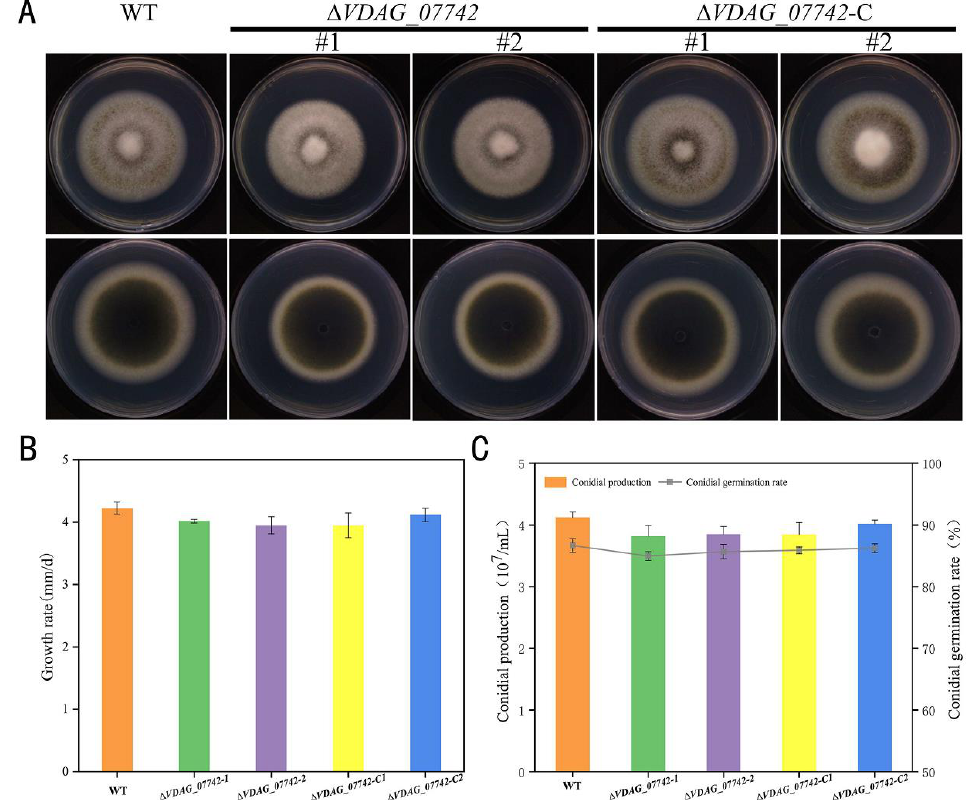
Figure 6. Analysis of fungal growth, conidial production, and conidial germination rate of VDAG_07742 deletion mutants. ( A ) Colony morphology of wild-type (WT) Verticillium dahliae strain JY, knockout mutants ∆VDAG_07742 -1 and ∆VDAG_07742 -2 and complementary mutants ∆VDAG_07742 -C1 and ∆VDAG_07742 -C2 cultured on PDA plates for 10 d; ( B ) colony growth rate; ( C ) conidial production and conidial germination rate. Values on the vertical axis represent the mean ± standard error (SE) for three biological replicates. Asterisks represent significant differences relative to the WT, as determined by the least significant difference (LSD) test at p = 0.05. 2.7. Conserved Hypothetical Protein VDAG_07742 is Required for V. dahliae Pathogenicity to Potato Plants